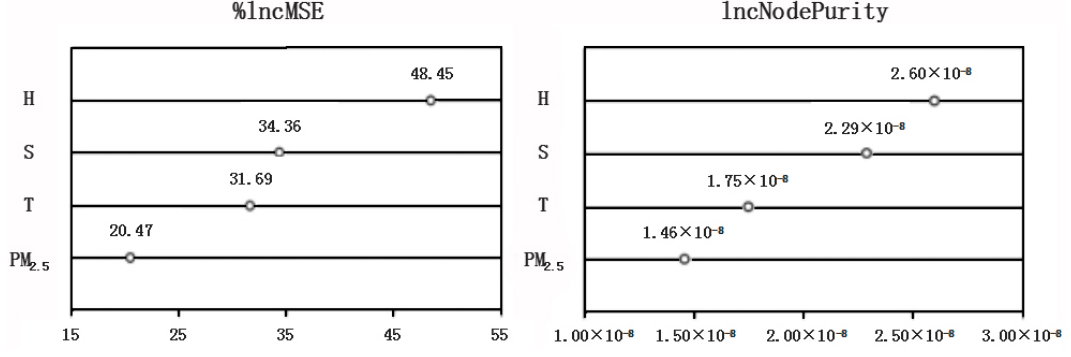
Figure 5. Importance ranking of independent variables. * %IncMSE represents the percent increase of the mean square error, IncNodePurity represents the increase of node purity, T represents temperature, H represents humidity, and S represents (total) radiation.